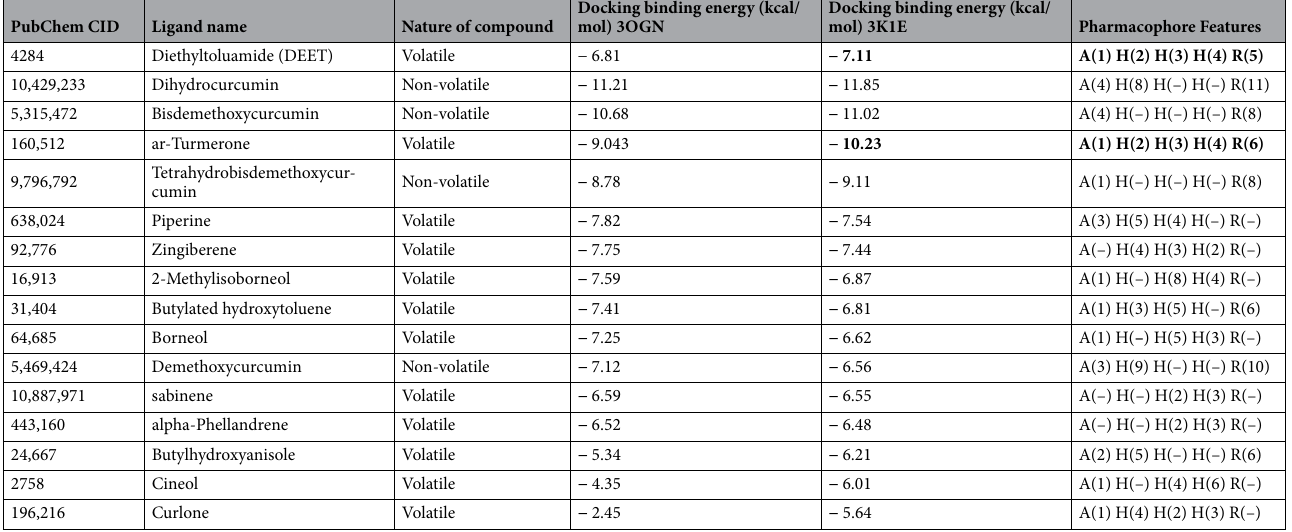
Table 1. List of phytochemicals from C. longa , their nature, binding energy, and pharmacophore features. A = proton acceptor, H = hydrophobic, and R =